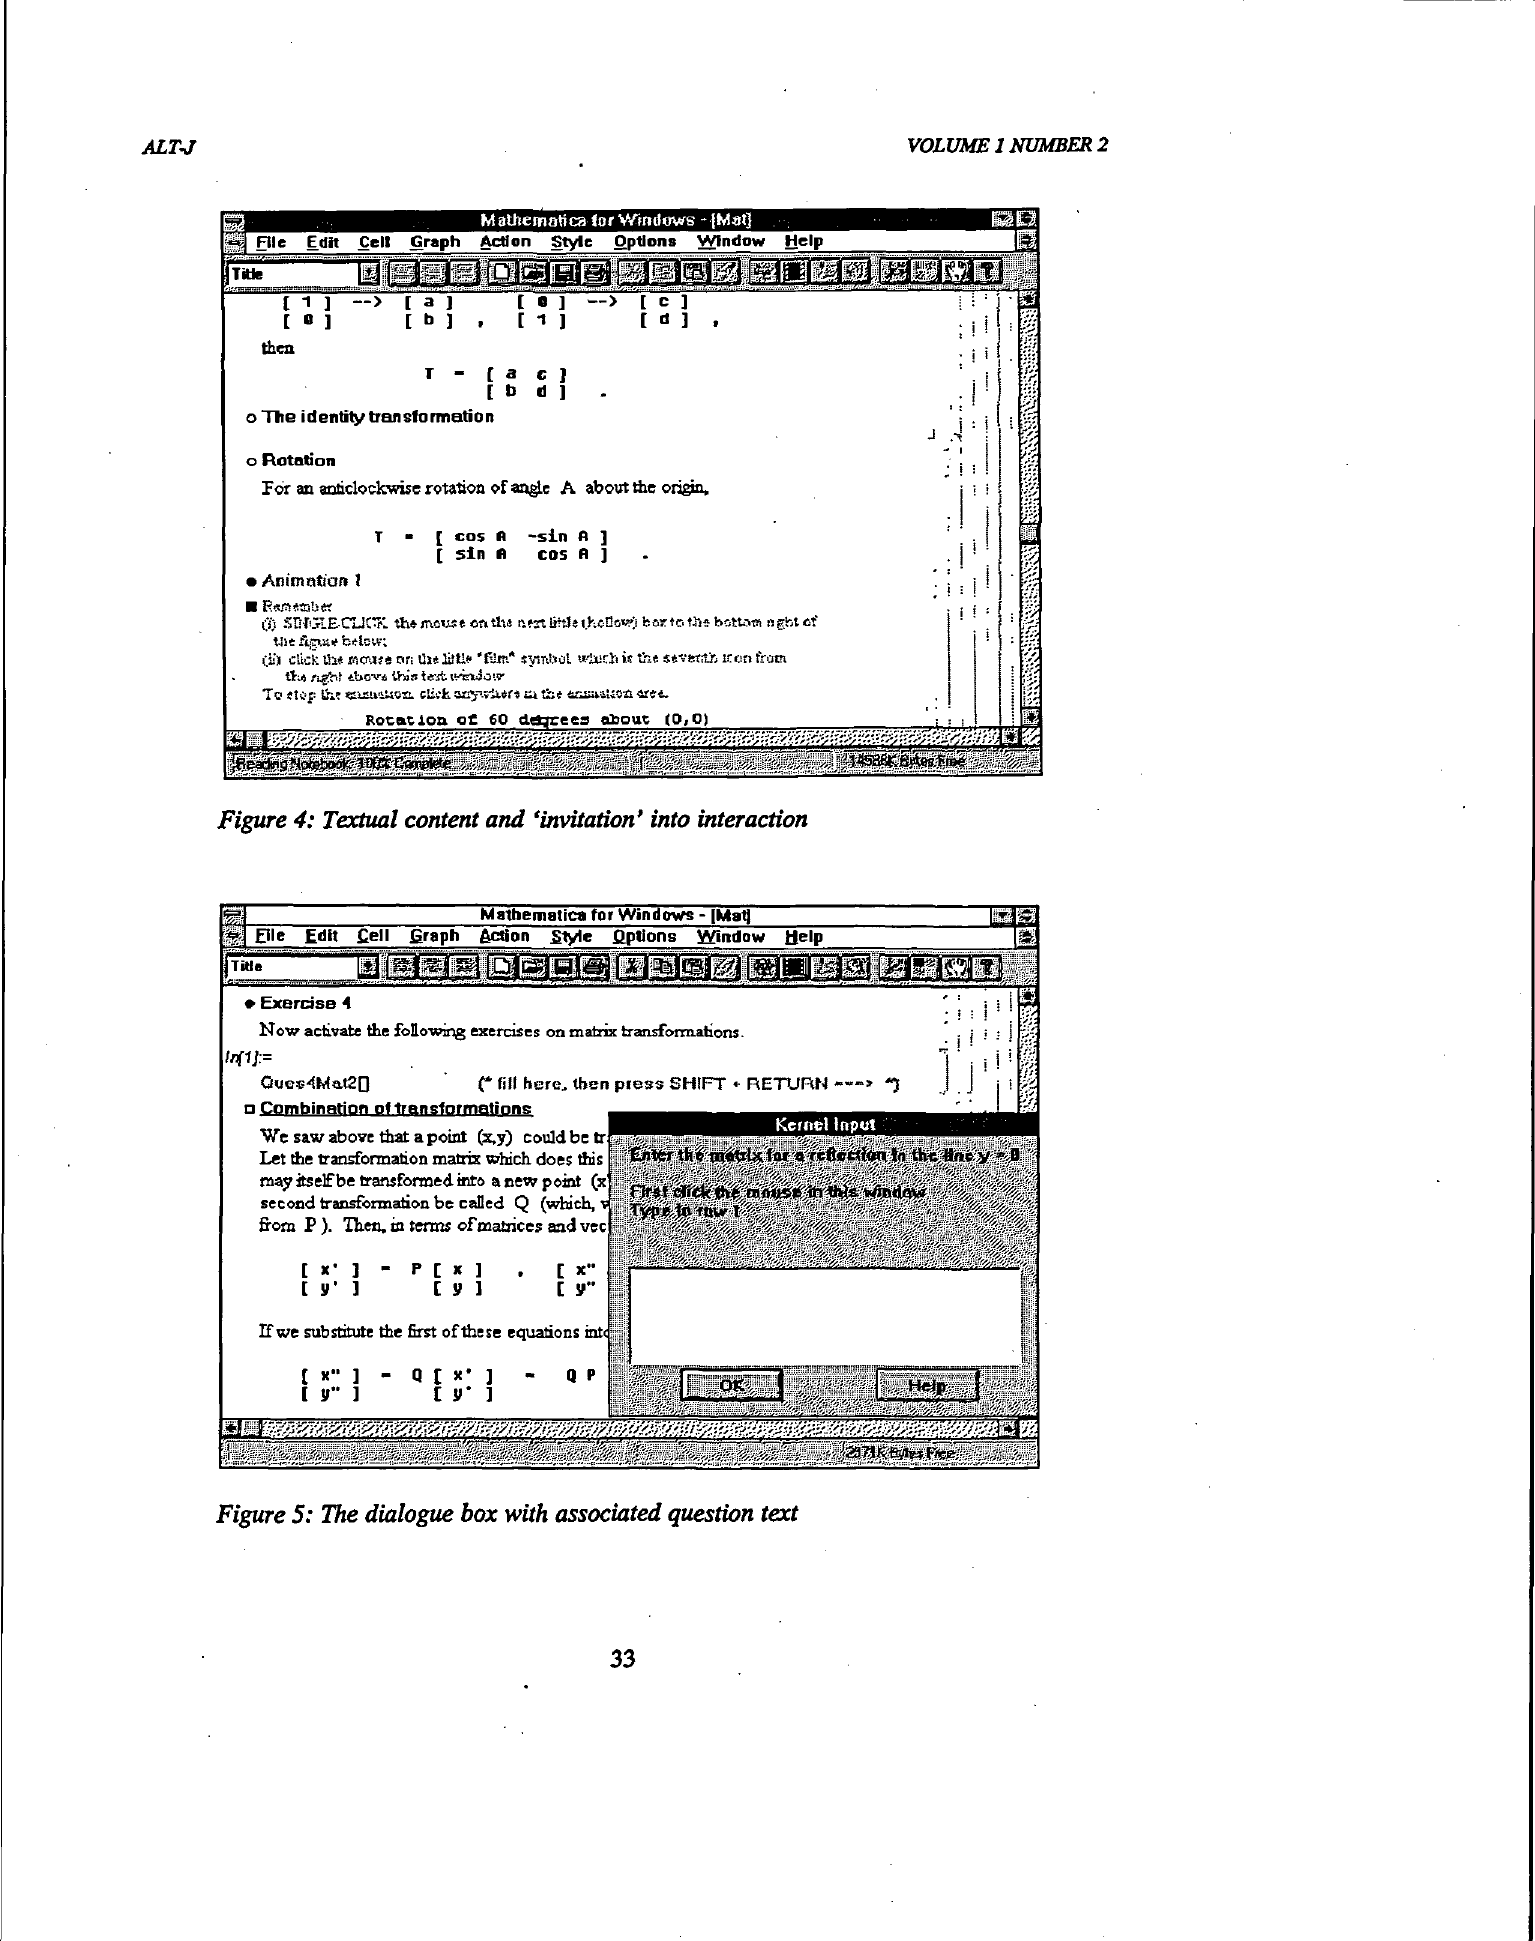
Figure 5: The dialogue box with associated question